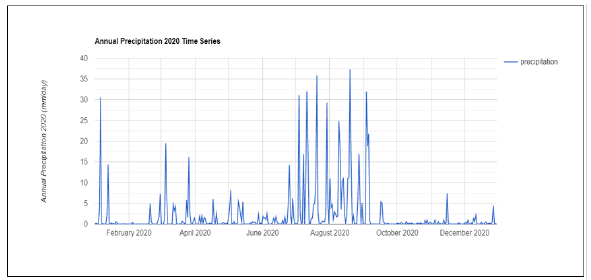
Figure 5: Results (CHIRPS , Precipitation (mm/day)) In figure-8 here, LST variation for Chandigarh city is shown for the state of Punjab, the annual temperature variation can be seen for the year 2018 where light glow signifies the annual day temperature varying less than -1.5 degree Celsius while light brown region indicates annual day temperature varying from 0 to 1.5 degree Celsius.